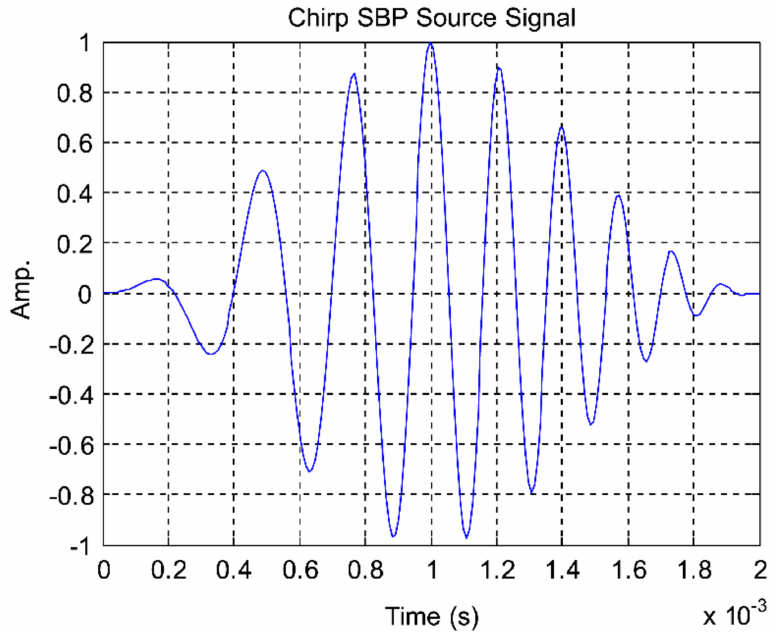
Figure 2. Tapered Chirplet: Chirp frequency of 2–7 kHz over a 2 ms